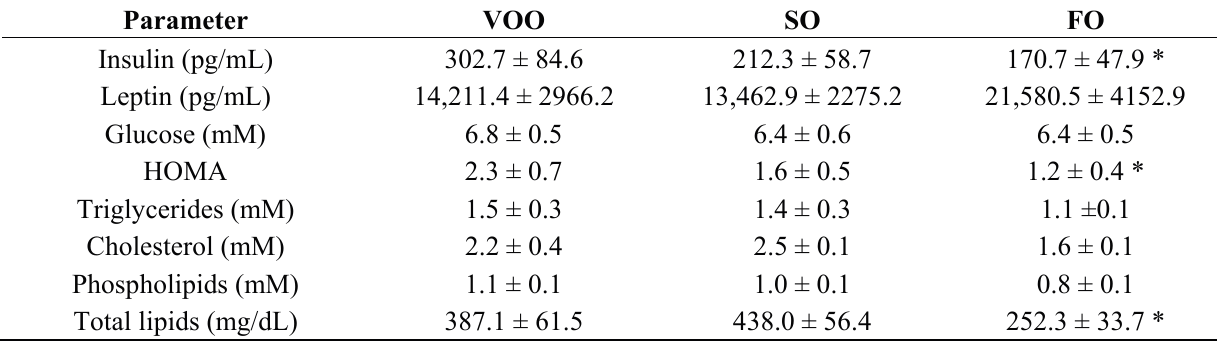
Table 1. Circulating parameters of rats fed on CoQ supplemented diet based on virgin olive oil (VOO), sunflower oil (SO) and fish oil (FO) at the end of the experimental